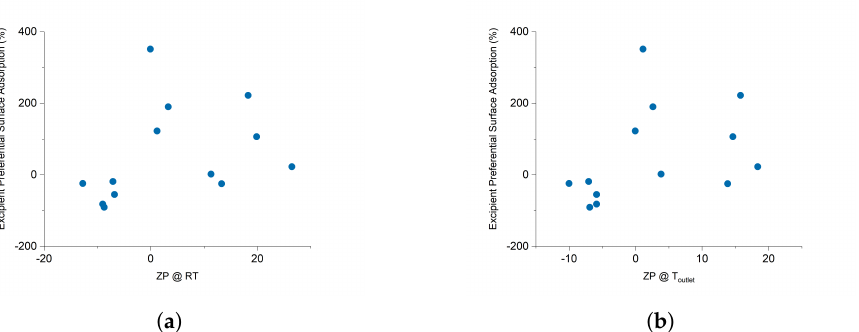
Figure A10. Preferential surface adsorption of excipient is not predicted by zeta potential. One sample (7-1[med-OH]) was statistically eliminated by the Grubbs outlier test [23]. ( a ) Preferential surface adsorption vs. zeta potential at room temperature (25 °C) ( b ) Preferential surface adsorption vs. zeta potential at T outlet (70